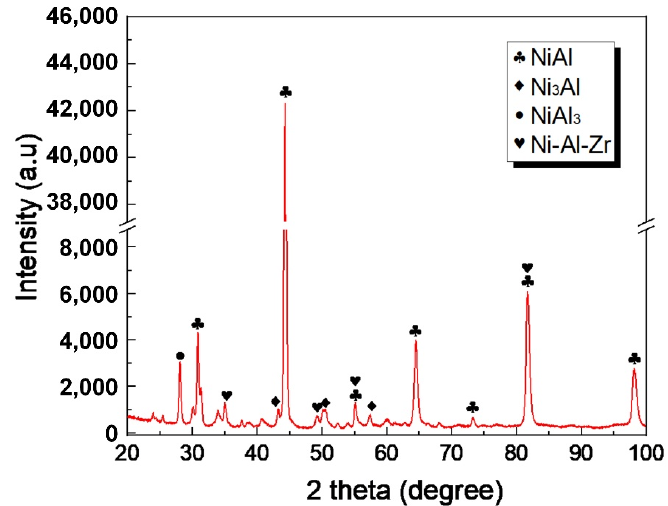
Figure 10. XRD results of Al/Ni/Zr interlayer products.